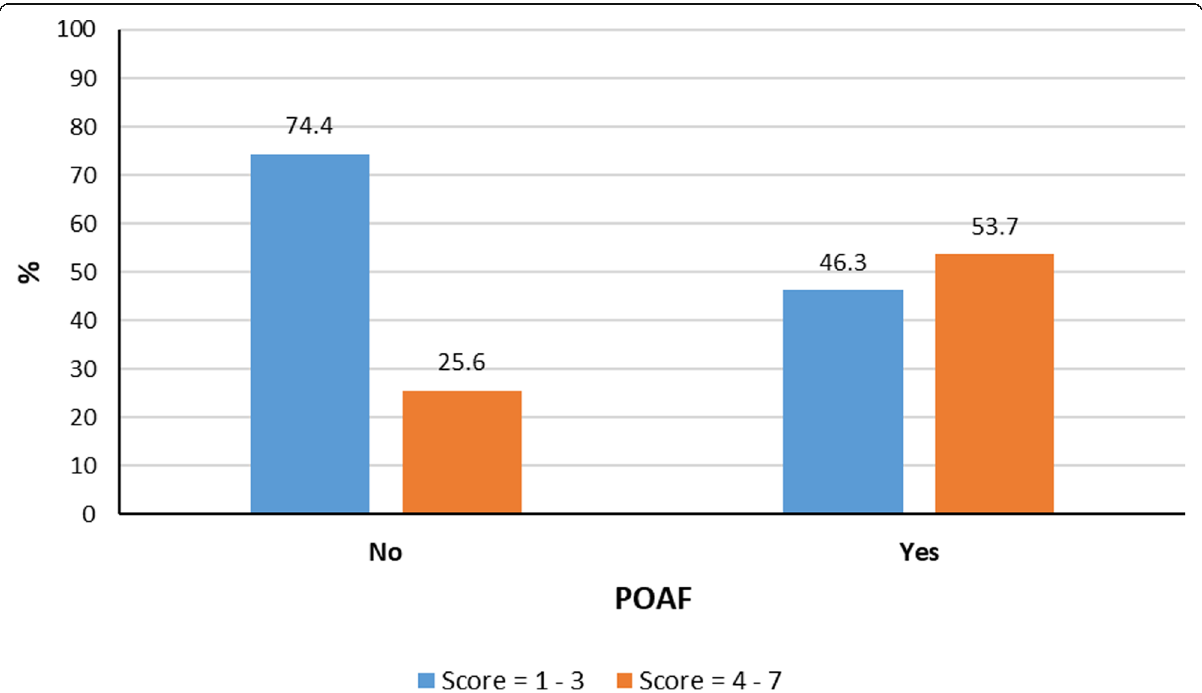
Fig. 1 The association between postoperative atrial fibrillation and CHA 2 DS 2 -VASc score ( P = 0.002)